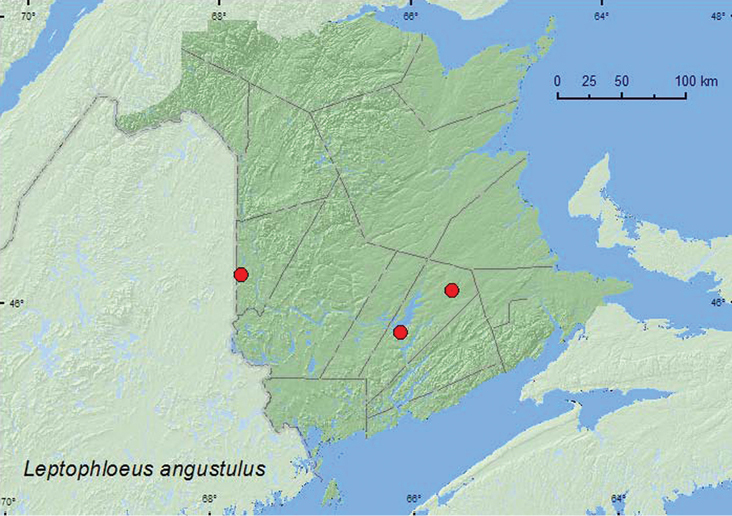
Collection localities in New Brunswick, Canada of Leptophloeus angustulus.